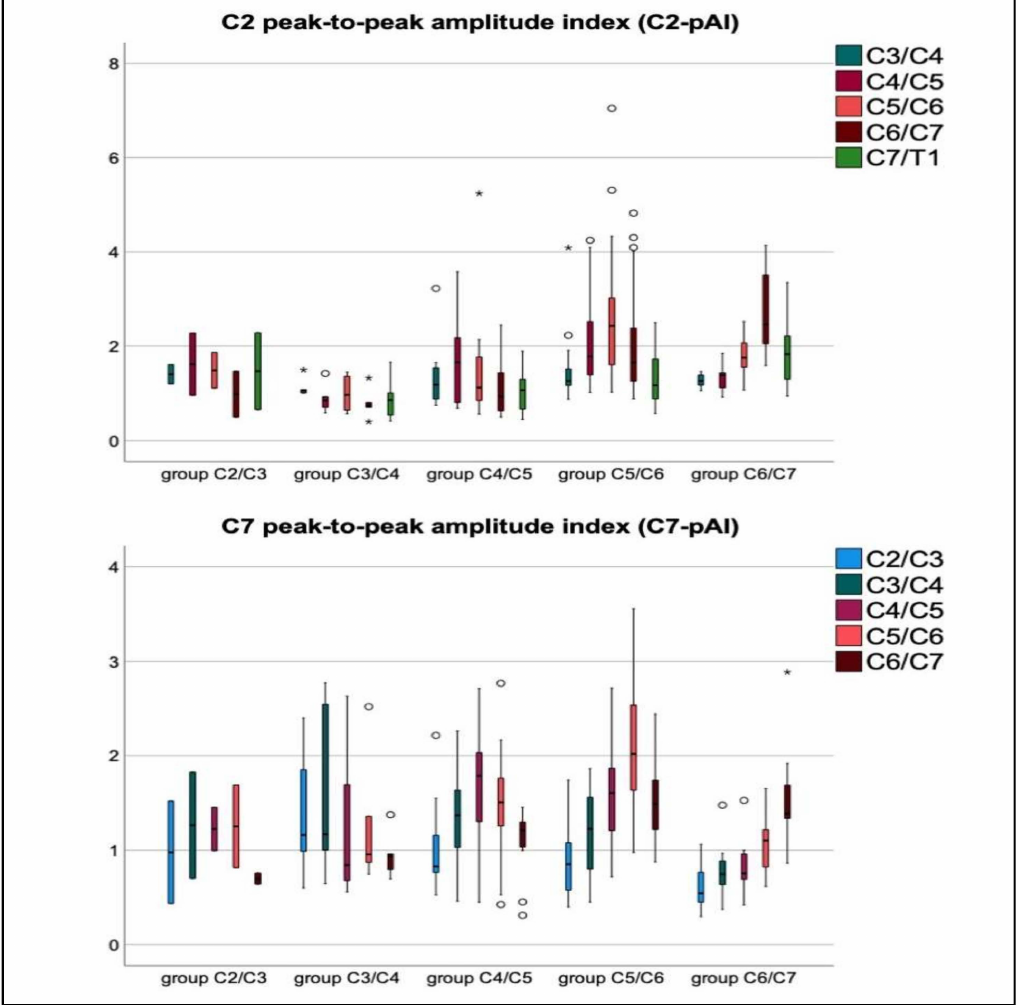
Figure 4. Boxplots of the C2-peak-to-peak amplitude index (C2-pAI, top row) and the C7-peak-to-peak amplitude index (C7-pAI, bottom row). The pAI references the spinal cord peak-to-peak amplitude per segment to the individual’s spinal cord peak-to-peak amplitude at the cranial segment C2/C3, or to the caudal segment C7/T1. Cranial levels of stenosis are best reflected by the C7-pAI, caudal stenosis by the C2-pAI. An increase ( y -axis) toward the stenotic level per group ( x -axis) followed by a decrease is shown, indicating a stretching of the spinal cord tissue cranial of the level of stenosis followed by a mechanical compression of tissue at the caudal segments. Increase and decrease were significant among the groups of patients with stenosis at C4/C5, C5/C6, and C6/C7. Mild outliers are indicated by ◦ (1.5 to 3.0 × interquartile range), extreme outliers by * (>3.0 × interquartile